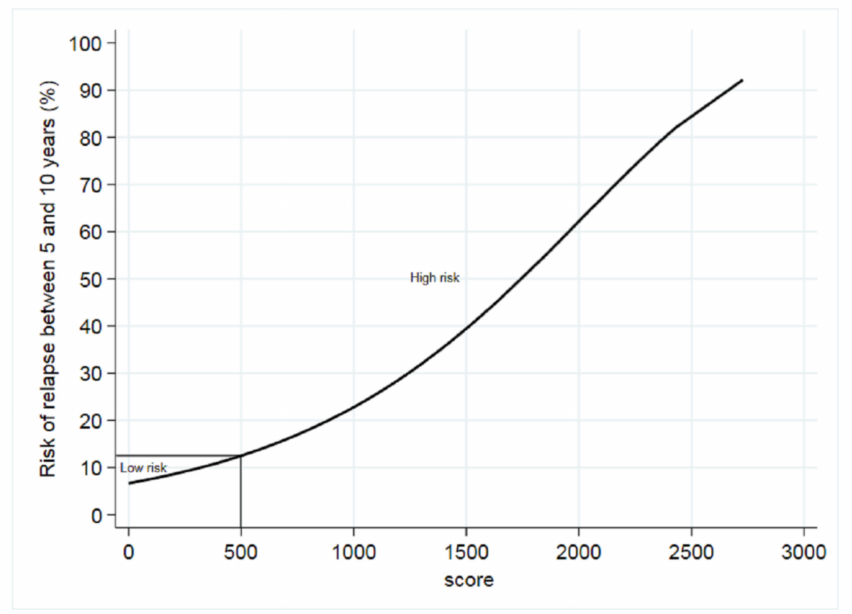
Figure 1. Risk of relapse between five and ten years according to the score. It corresponds to the cumulative risk of local–regional and metastatic relapse in low-risk patients five to ten years after diagnosis. We represented the risk of relapse-free survival after the end of endocrine therapy (ET) according to the score. The solid vertical line indicates the cut-o ff point for at-risk